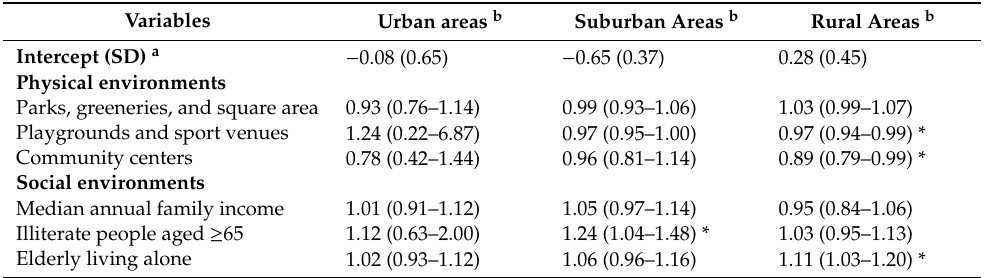
Table 5. Odds ratio of Alzheimer’s dementia in relation to environmental features # and individual characteristics in the residential township by level of